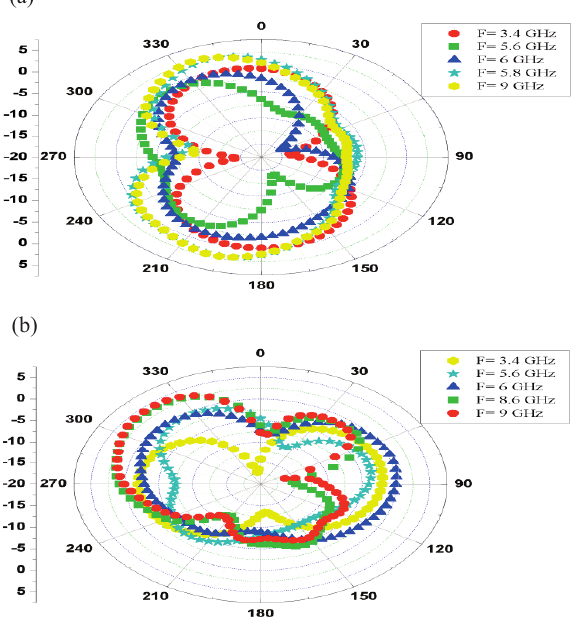
Fig. 7. Simulated radiation pattern of the proposed antenna: (a) H­plane at 3.4, 5.6, 6, 8.6, and 9 GHz, (b) E­plane at 3.4, 5.6, 6, 8.6, and 9